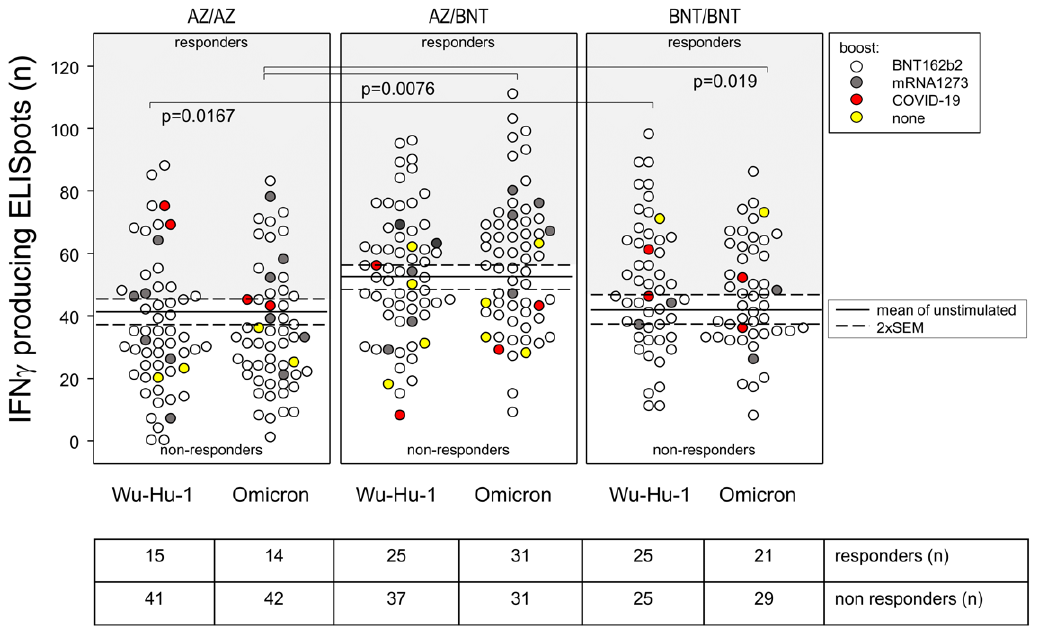
Figure 4. T cell memory against the Wu-Hu-1 spike protein and its Omicron variant were comparable, yet AZ-primed T cells respond less well to peptide pools. Dot plots show absolute numbers of IFNγ -producing ELISpots resulting from 5 × 10^5 PBMCs stimulated with peptide pools representing either the wild-type spike protein (Wu-Hu-1) or its Omicron variant. Horizontal lines indicate means ± 2 SEM of IFN γ -producing ELISpots present in the absence of peptide-stimulation. Each dot represents one individual, and in the case of more than mean + 2 SEM IFNγ -producing ELISpots, individuals were considered responders. p values resulted from chi-squared tests, comparing the ratios of responders to non-responders among vaccination groups. AZ/AZ: homologously primed with AZD1222, AZ/BNT: heterologously primed with AZD1222 and BNT162b2, BNT/BNT: homologously primed with BNT162b2. The color code indicates boost variants.